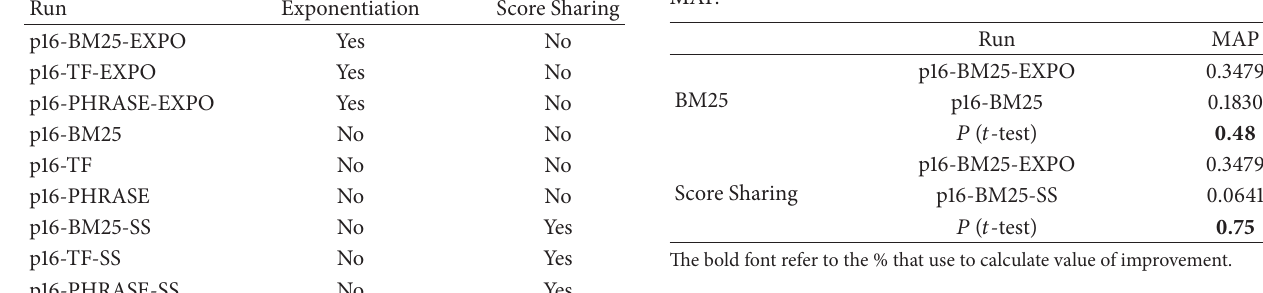
Table 6: The significance ( 𝑃 ) is computed with a 2-tailed 𝑡 -test at